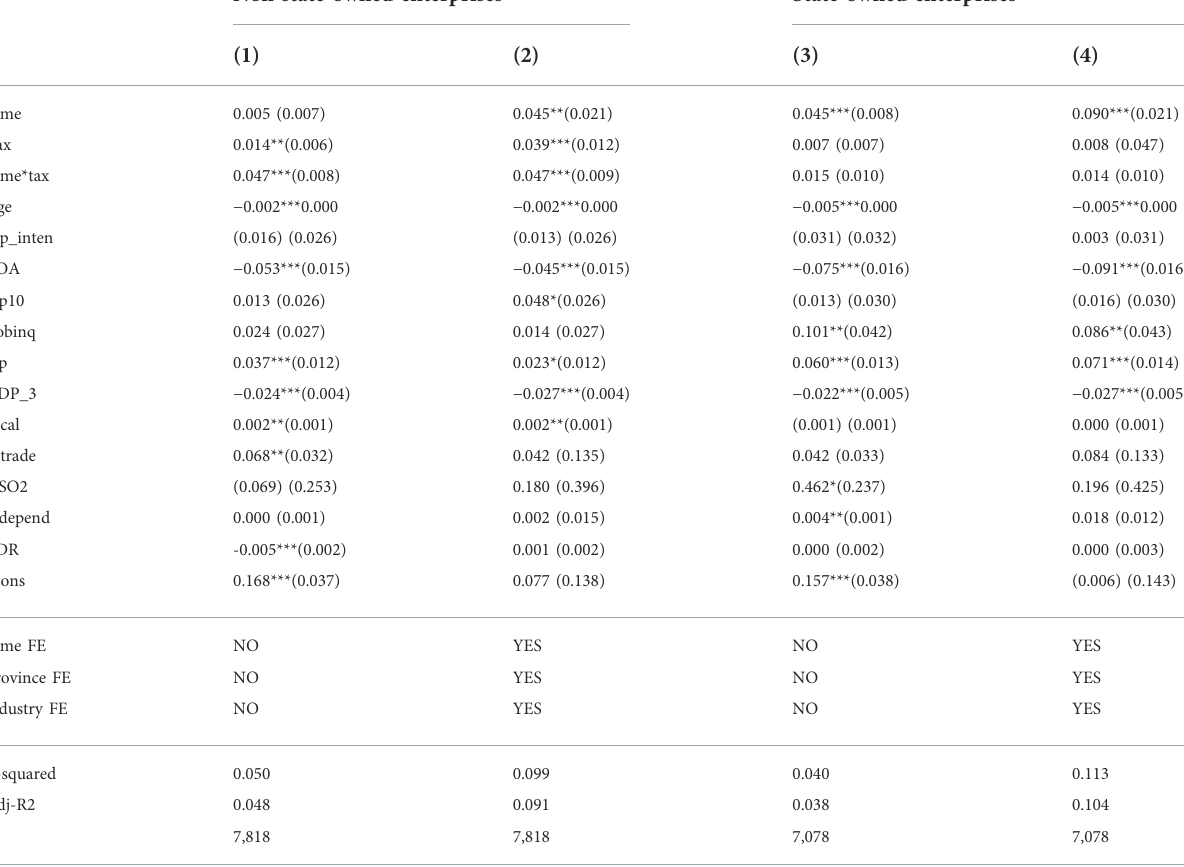
TABLE 10 Robustness test regression results: Property rights